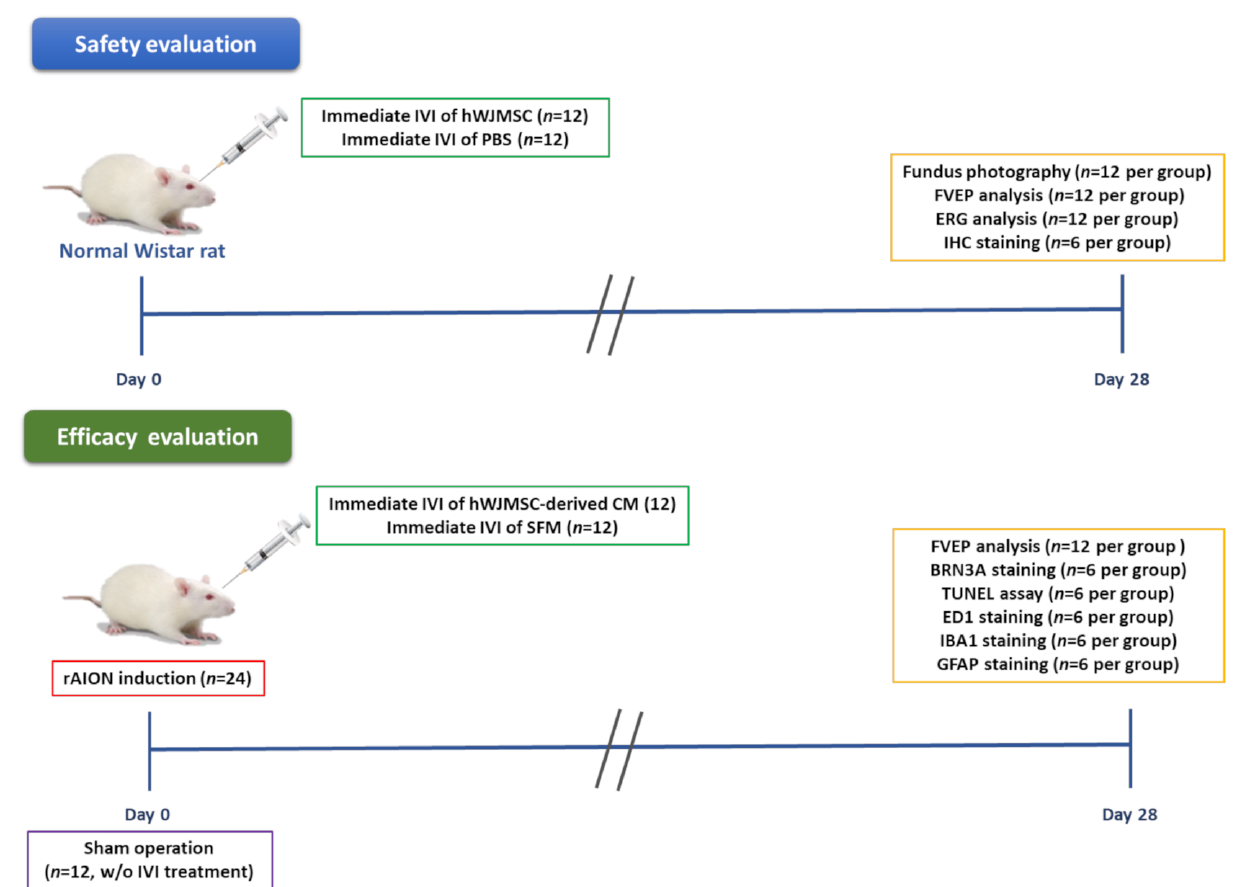
Figure 9. Study design to evaluate the safety and the efficacy of intravitreal MSC-based therapies. The safety of intravitreal injection of hWJMSC was investigated in the normal Wistar rat by using fundus photography, FVEP, ERG, and IHC analysis. The therapeutic effects of intravitreal injection of the hWJMSC-derived CM were evaluated in the rAION model by using FVEP, Brn3a staining, TUNEL assay, ED1 staining, Iba1 staining, and GFAP